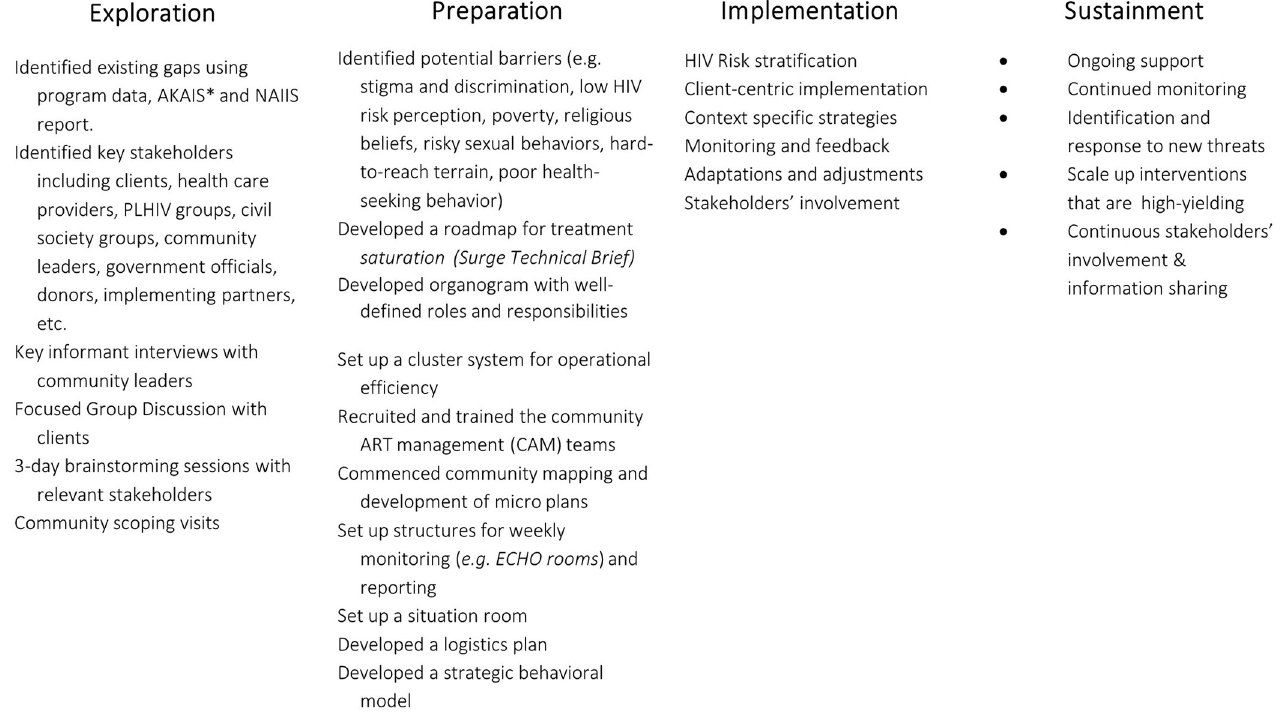
Fig 1. Adapting EPIS framework for the ART surge implementation in Akwa Ibom, Nigeria (April 2019–March 2021). � AKAIS: Akwa Ibom AIDS Indicator Survey.